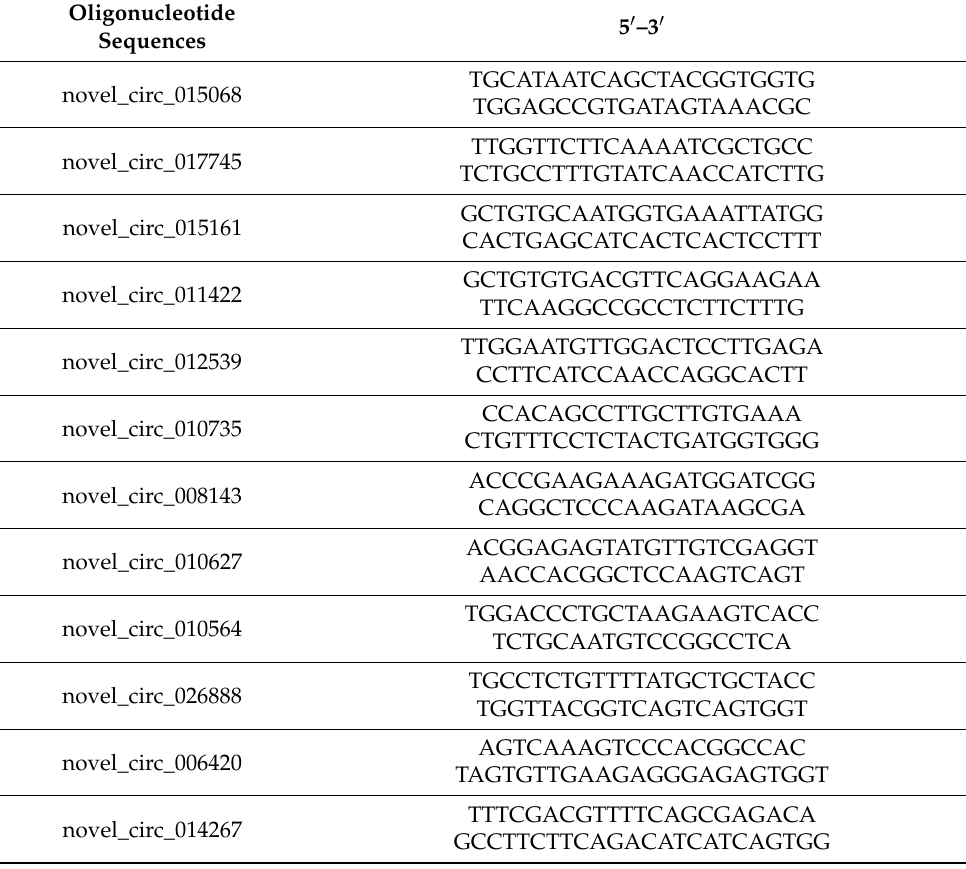
Table 1. Primers used for validating the expression of circRNAs.